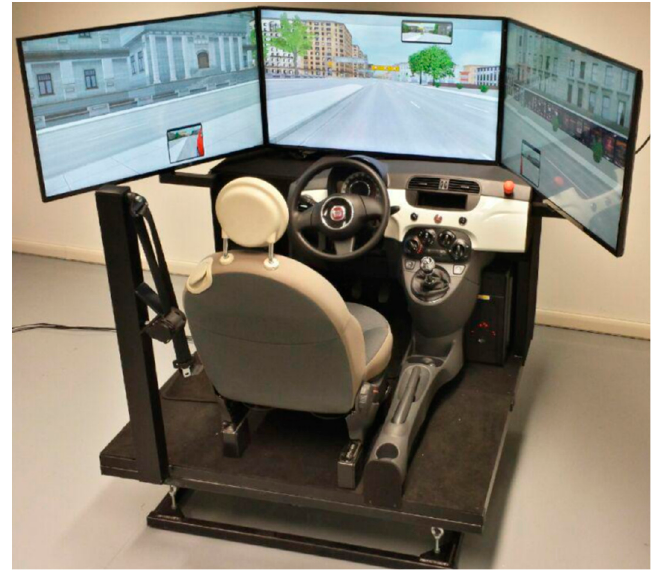
Figure 1. The AutoSim 1000-M car simulator.